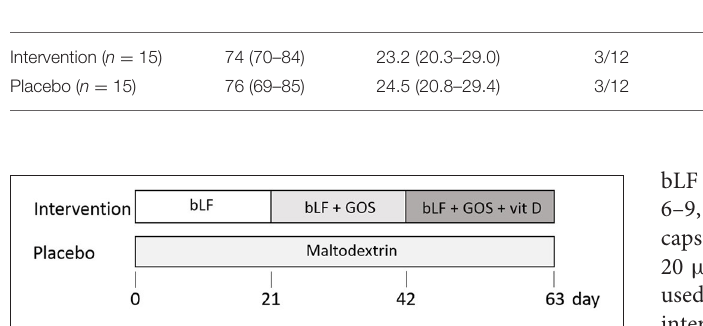
FIGURE 1 | Nutritional intervention study design. The intervention group ( n = 15) received bovine lactoferrin (bLF) for 3 weeks (days 0–21), followed by 3 weeks of bLF + Galacto-oligosacharides (GOS) (days 21–42) and 3 weeks of bLF + GOS + vitamin D. The placebo group ( n = 15) received maltodextrin for 9 weeks (days 0–63). At study days 0, 21, 42, and 63, blood was